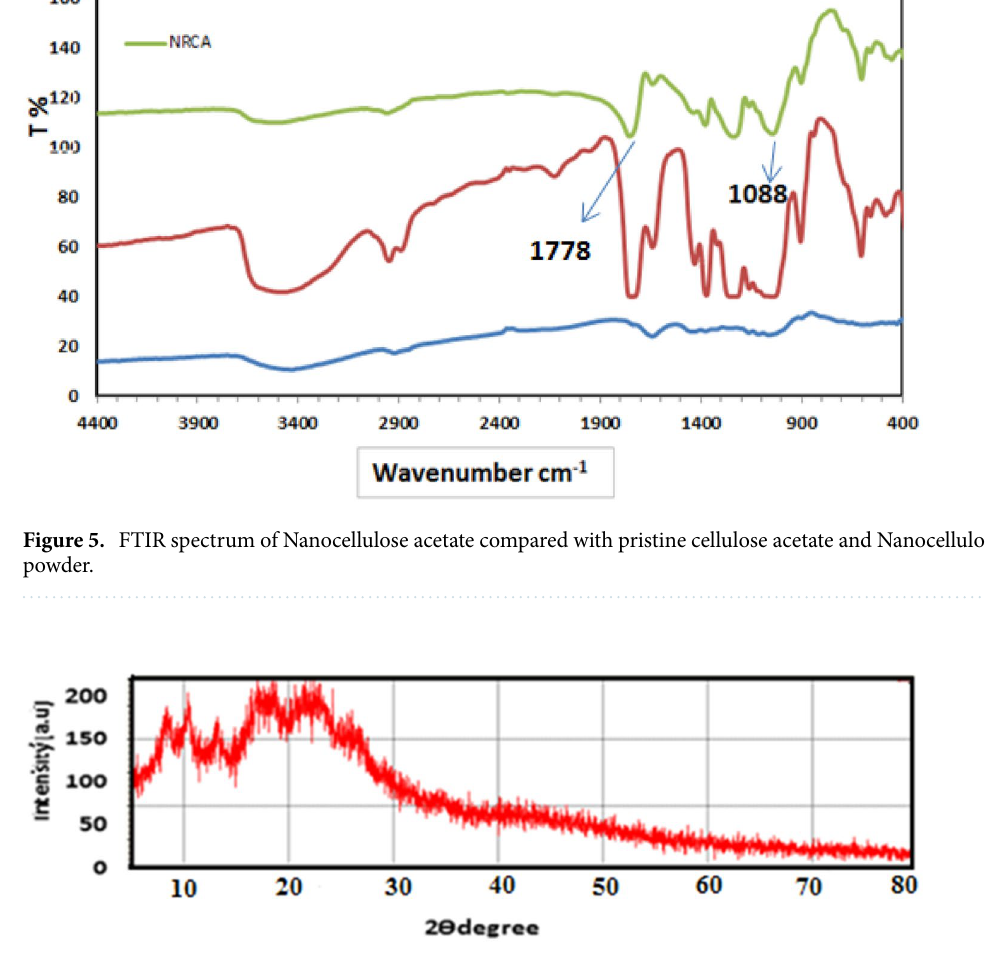
Figure 6. XRD patterns Nanocellulose acetate prepared from rice